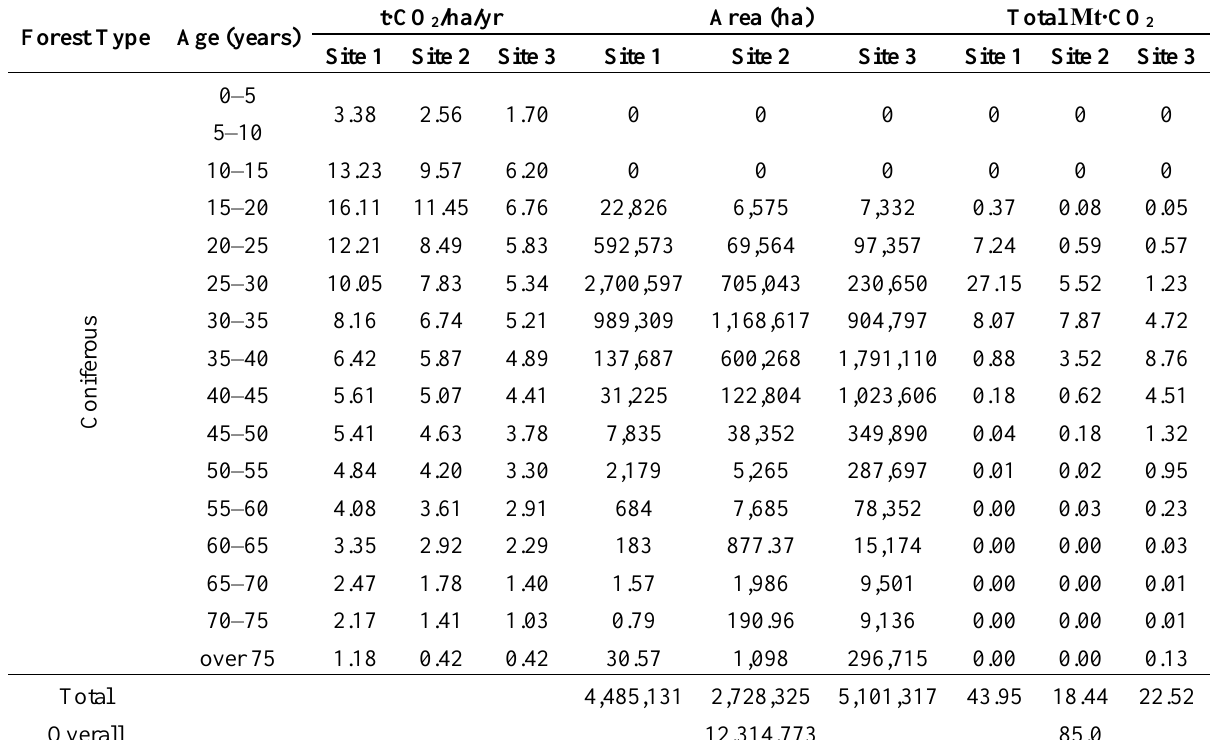
Table 3. CO 2 sequestration of coniferous forests by tree age using the PALSAR data and the stem volume